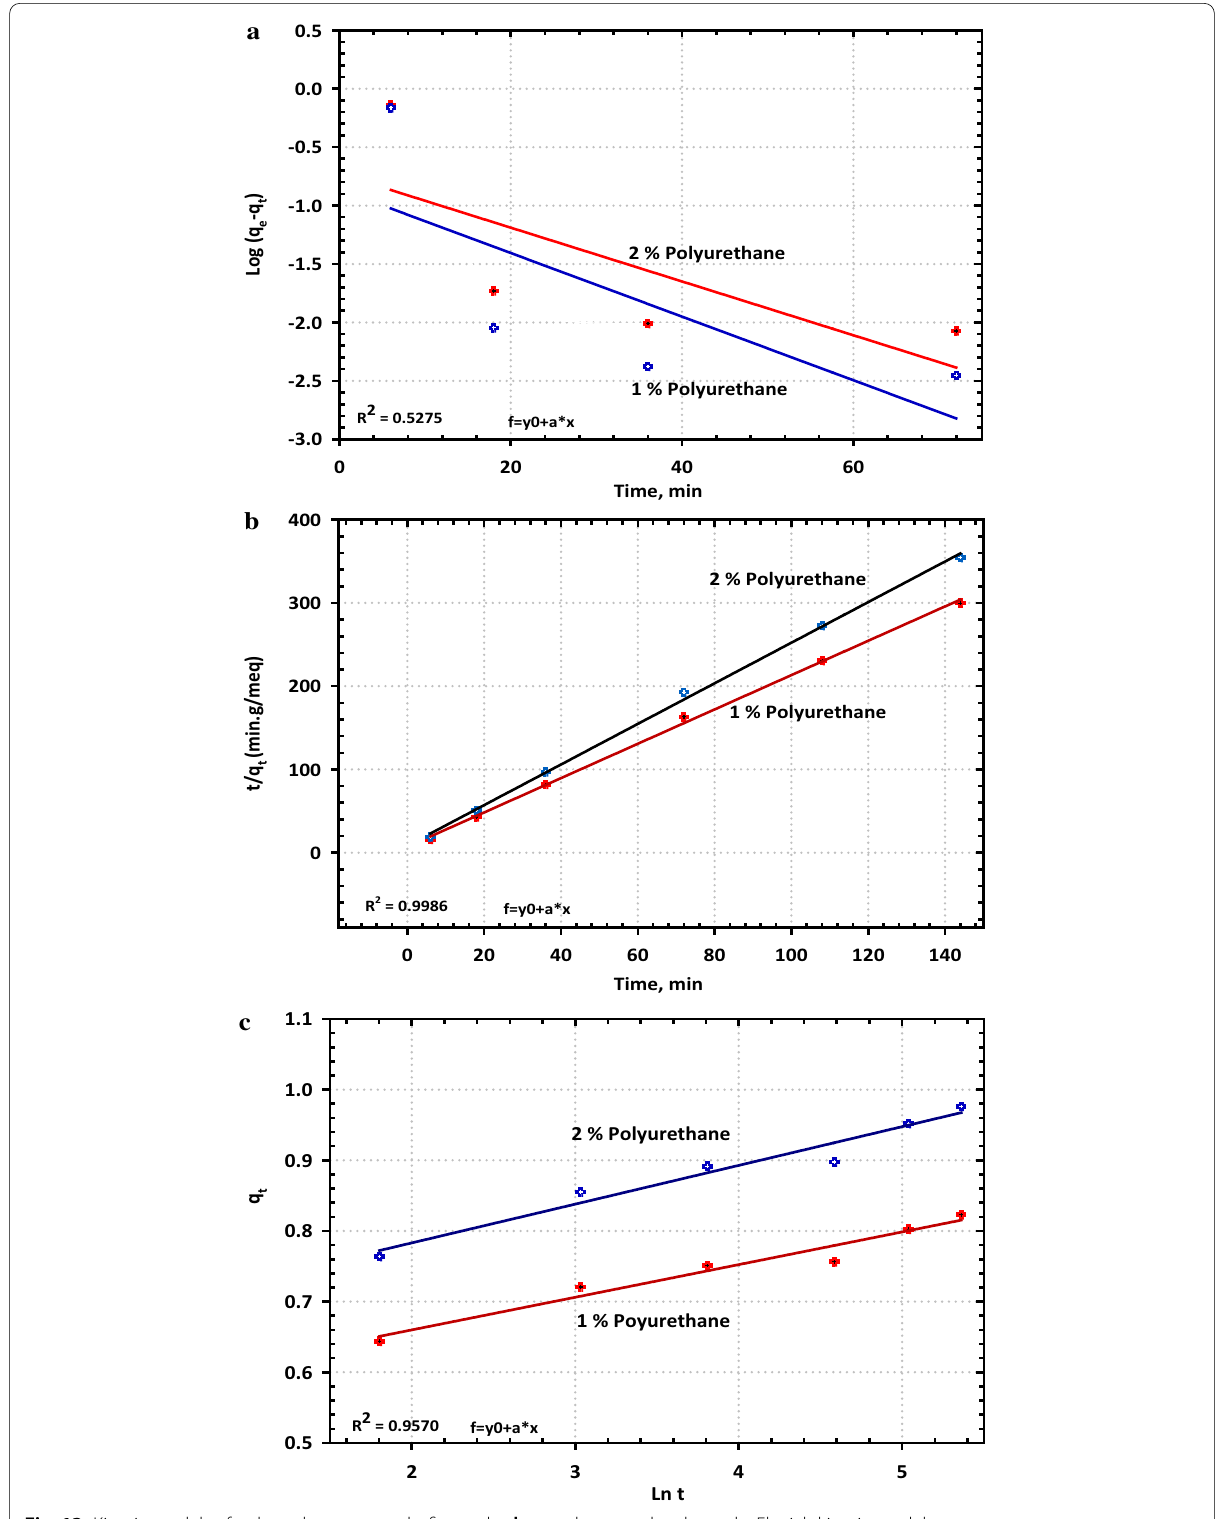
Fig. 13 Kinetic models of polyurethane a pseudo‑first‑order, b pseudo‑second‑order and c Elovich kinetic